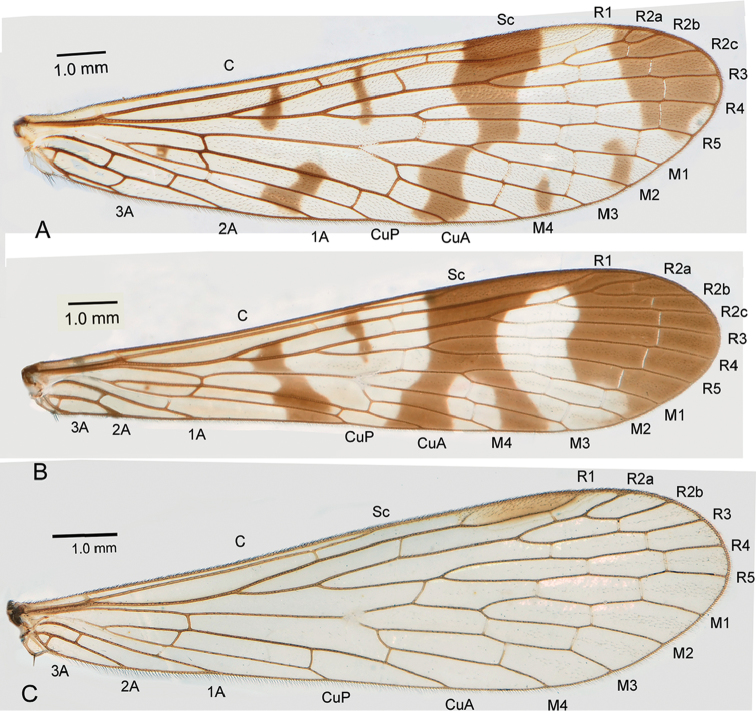
Forewings of male Panorpidae. APanorpacommunisBNeopanorpapulchraCPanorpabashanicola sp. n.